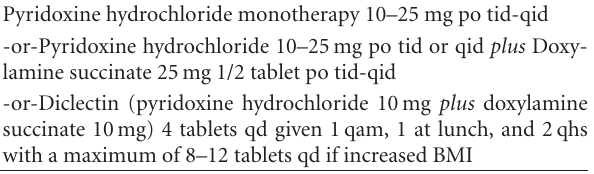
Table 2: Early pharmacotherapies for NVP/HG. First-line